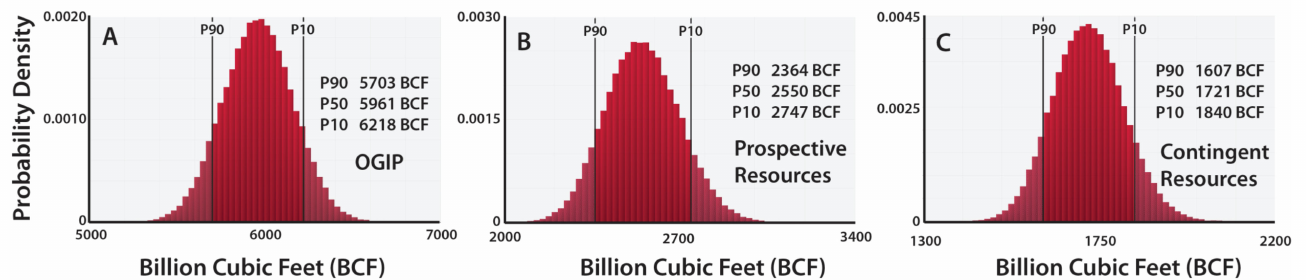
Figure 14. Probabilistic distribution for ( A ) original gas in place (OGIP), ( B ) Prospective Resources, and ( C ) Contingent Resources in the hypothetical case study area.